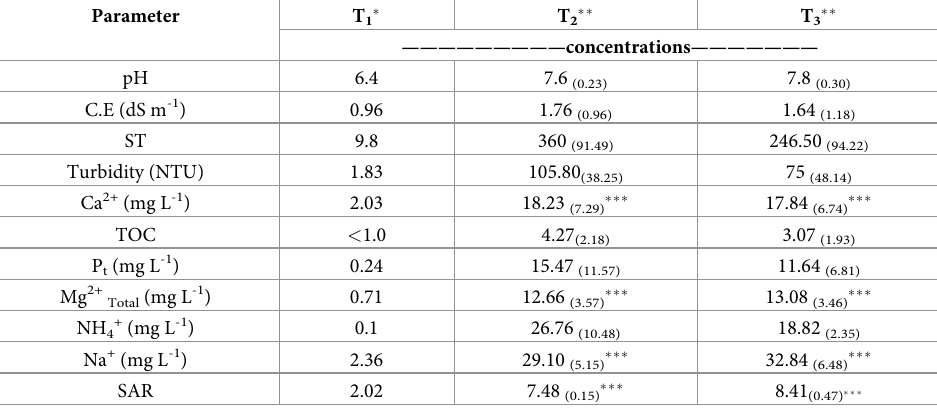
Table 1. Physicochemical characterization of wastewater in different treatment scenarios and for the control